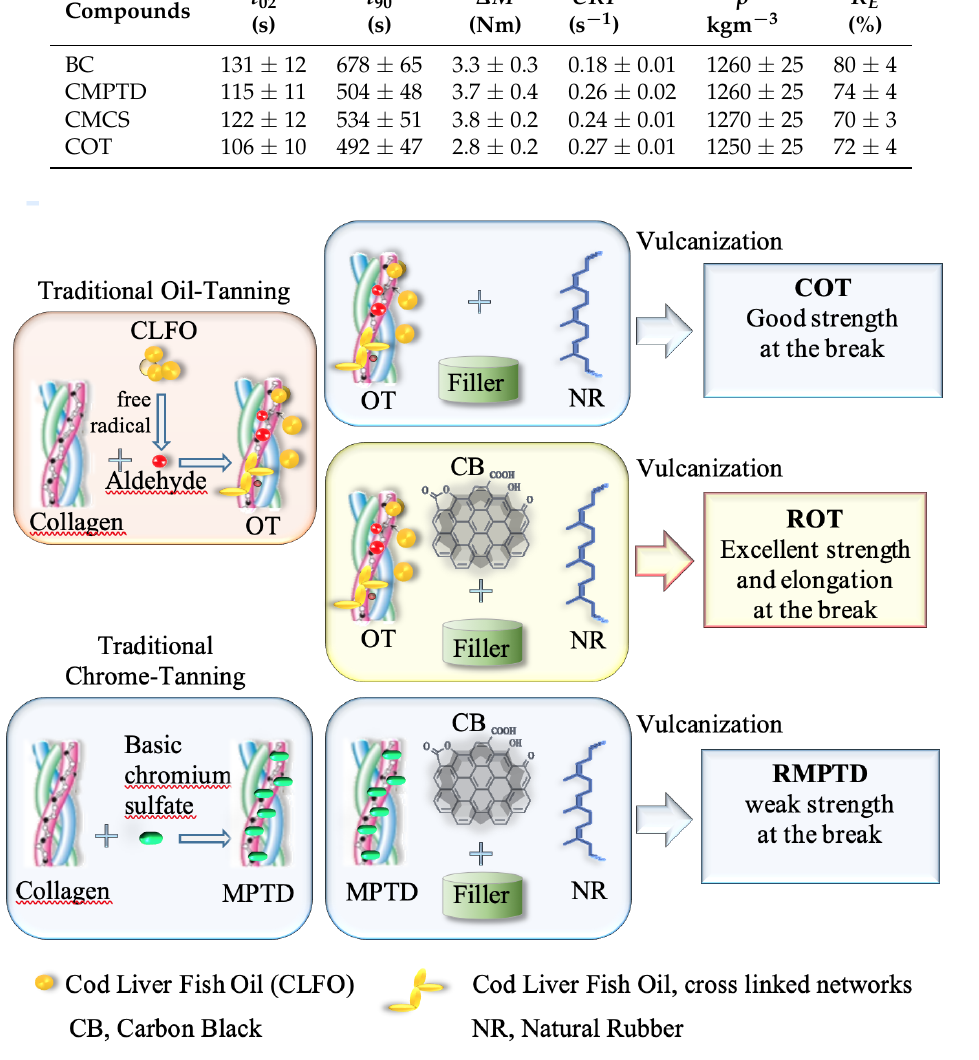
Figure 2. Schematic illustration of the fabrication process involving a cross-linking reaction between leather collagen fibers and natural rubber (NR), in which carbon black serves as